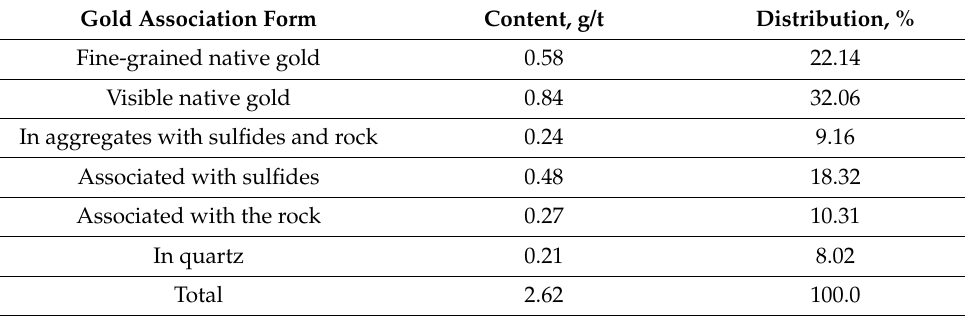
Table 3. Rational composition of gold in the ore